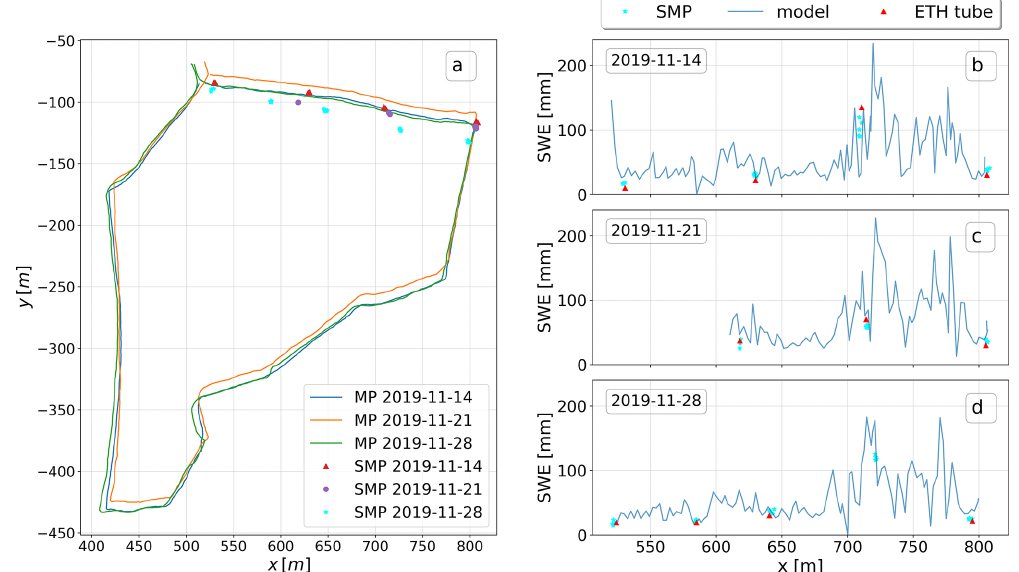
Figure 5. (a) SMP measurement locations along the Magnaprobe (MP) transect path on 14 (2019-11-14), 21 (2019-11-21) and 28 Novem- ber 2019 (2019-11-28). The GPS coordinates were transformed into local FloeNavi grid coordinates. Panels (b) , (c) and (d) show the compar- ison of SWE estimates from direct SMP measurements, direct bulk SWE measurements and SWE derived with the HS-SWE model from the Magnaprobe snow depth measurements along the northern transect as x -axis location on the FloeNavi grid, for 14, 21 and 28 November